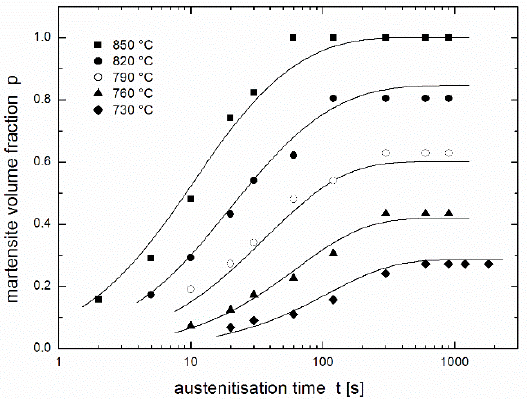
Figure 2. Martensite volume fraction in dual phase steel after austenitisation at various temperatures during various dwells [17] fitted using the equation of autoinhibition (3) and the Arrhenius equation (Equation (2)) (all temperatures were fitted together).